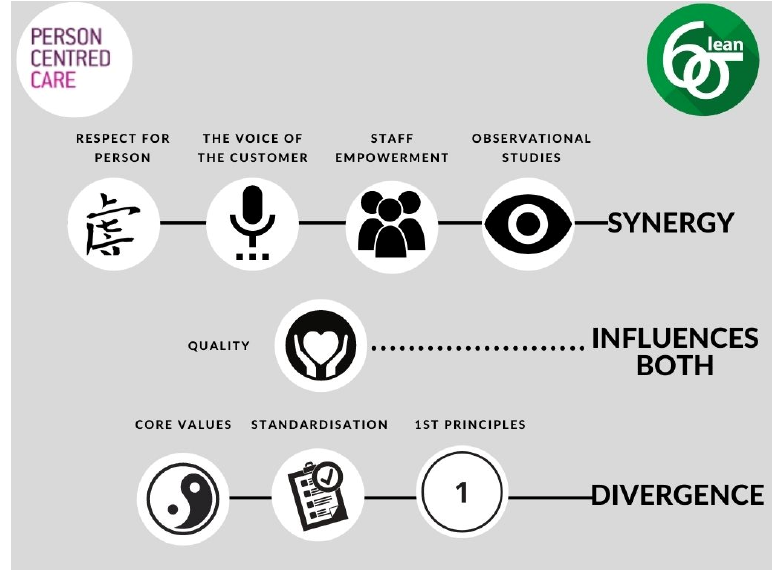
Figure 3. Synergy and divergence between LSS and person-centred care (Teeling, Dewing & Baldie, 2020).